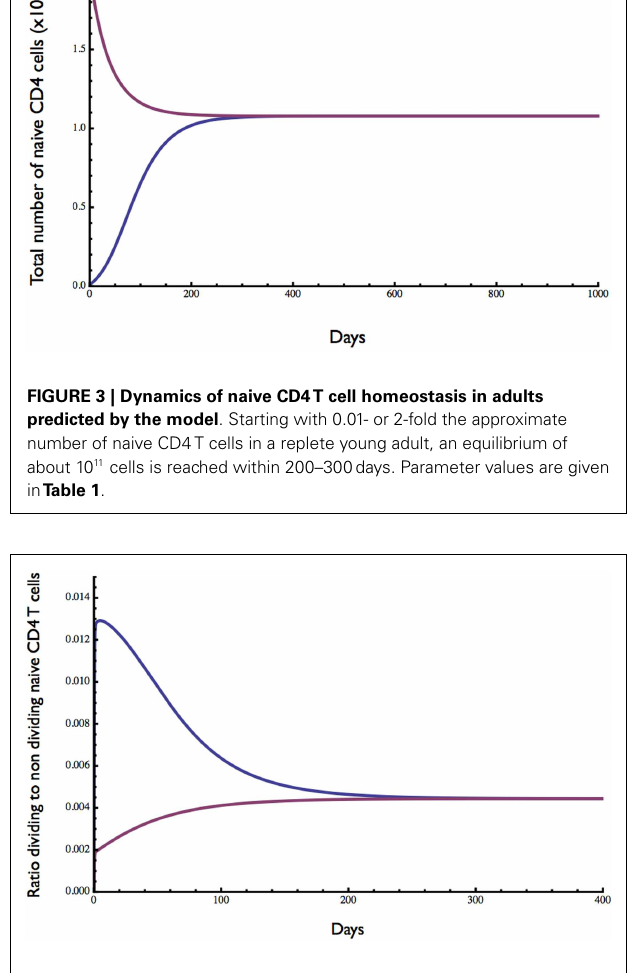
FIGURE 4 | Ratio of dividing to resting cells predicted by the model . Starting with 0.01 × 10 11 (blue curve) or 2 × 10 11 (red curve) the approximate ratio of dividing to resting cells changes over time to reach an equilibrium of about 0.4%. As expected, the proportion of proliferating cells is greater when the initial cell number is low. Parameter values used in the model are the same as in Figure 3